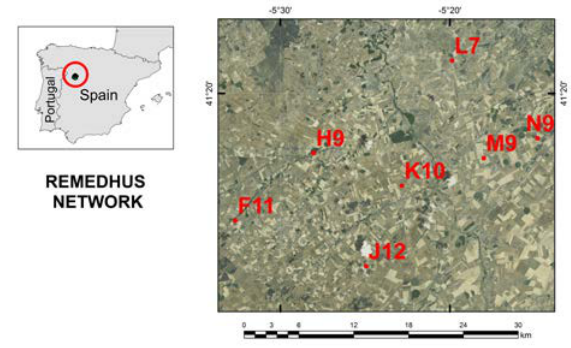
Figure 1. Study area and selected REMEDHUS stations.